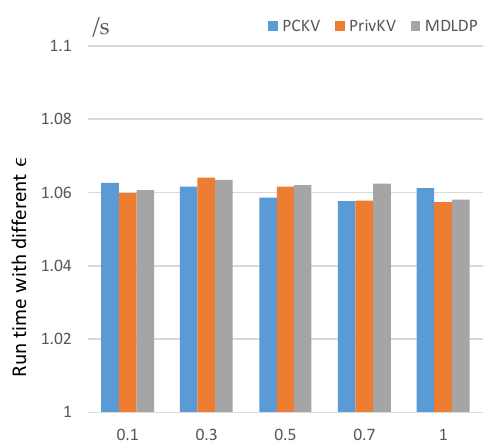
Figure 12. Run time with different 𝛜 .